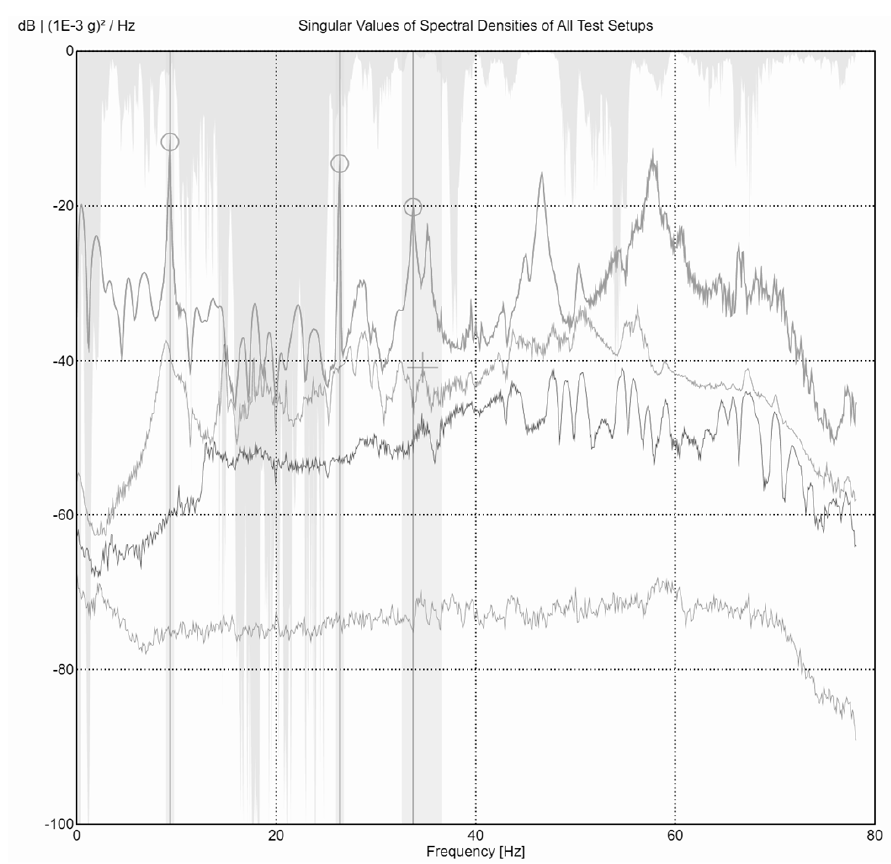
Figure 7. Dynamic identification test: ( a ) sensors placed during one setup and ( b ) axonometric scheme of the location of the sensors.